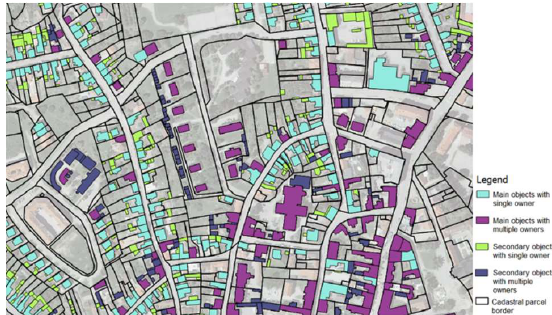
Figure 7. Preview of sample data from newly developed database categorized in four object datasets in QGIS desktop